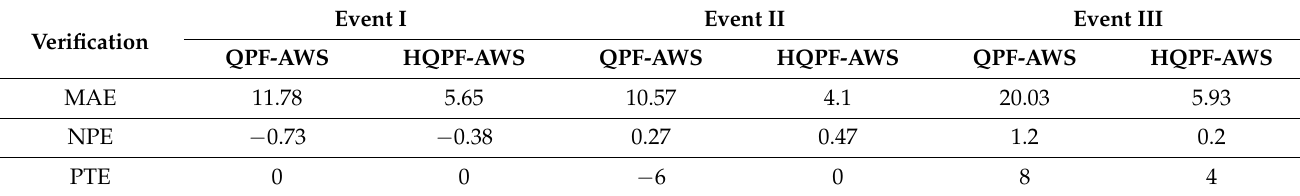
Table 1. Statistical Verification of QPF and HQPF (Events I, II, and